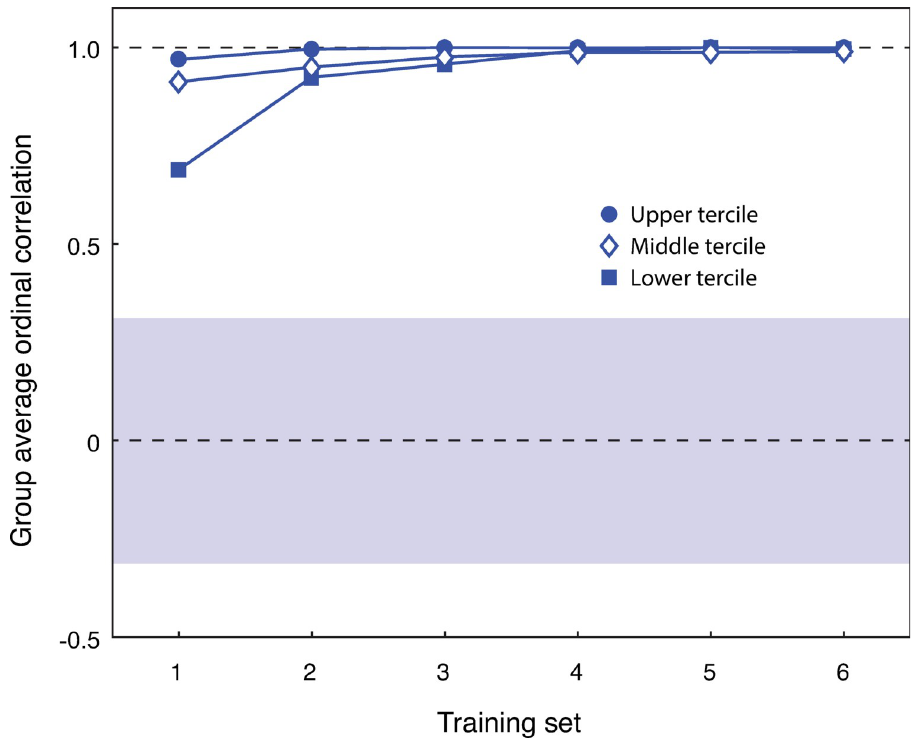
Fig 3. Spatial complexity group split into fastest (filled circle), middle (open diamond), and slowest (filled square) learning terciles as a function of training session (x-axis) by mean Spearman rank order correlation (y-axis). The blue bar represents the bootstrap 95% CI for the spatially ordered group. The dashed lines are for correlations of 0 (no correlation) and 1.0 (perfect correlation).